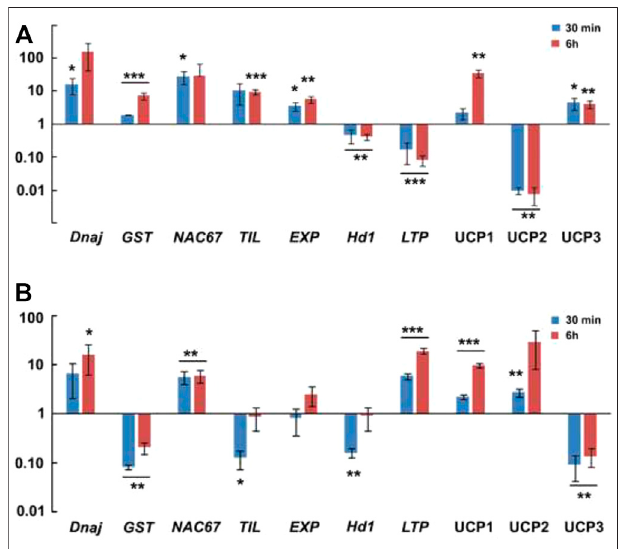
FIGURE 8 | Real time PCR validation of 10 target genes. (A) - In genotype 841-B. (B) - In genotype PPMI-69. Two tailed unpaired t -test